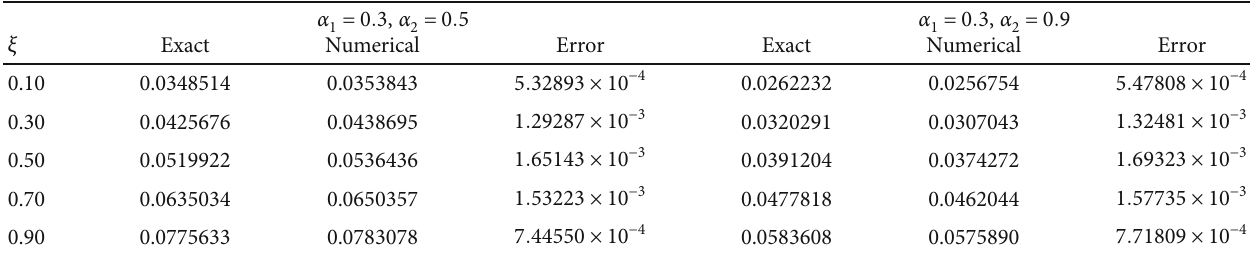
= 0 : 05 for Example 2. f